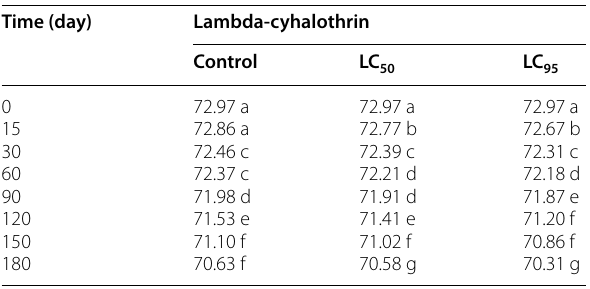
Table 9 Effect of lambda‑cyhalothrin on the total carbohydrates content in wheat grains during storage (0–180 days) Time (day)